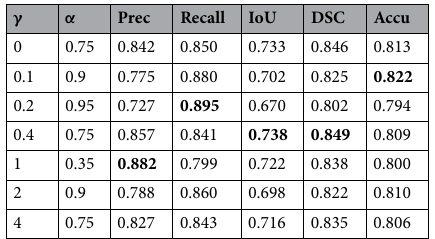
Table 3. The evaluation results (including IoU, DSC, and accuracy) of models trained by varying γ for FL loss (optimal α , dropout rate